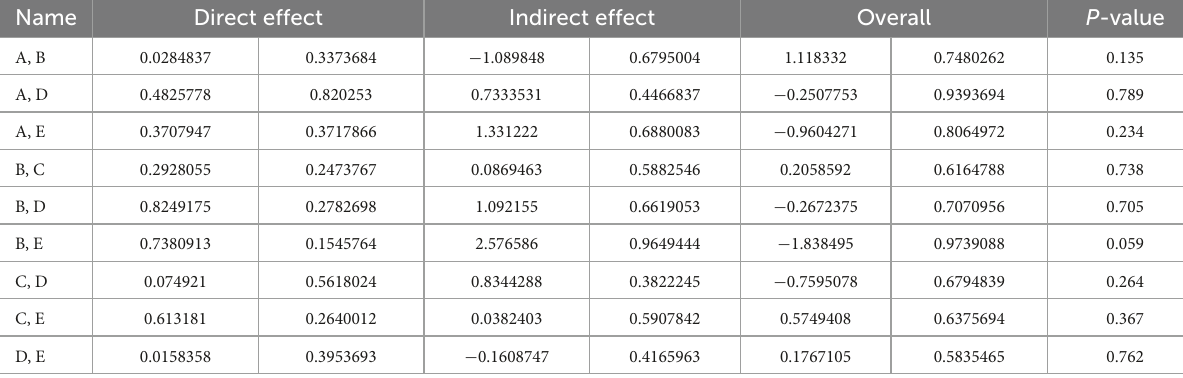
TABLE 2 Evaluation of local inconsistency for direct and indirect comparisons using node split model.